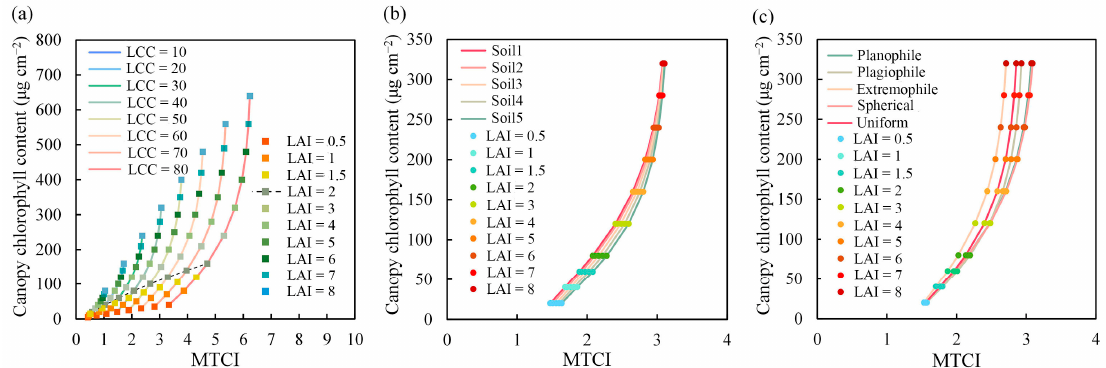
Figure 5. Sensitivity of MTCI to CCC. ( a ) ALA is spherical and the soil background is soil3. ( b ) LCC = 40 μ g cm − 2 , ALA is spherical. ( c ) LCC = 40 μ g cm − 2 , soil background is soil3.